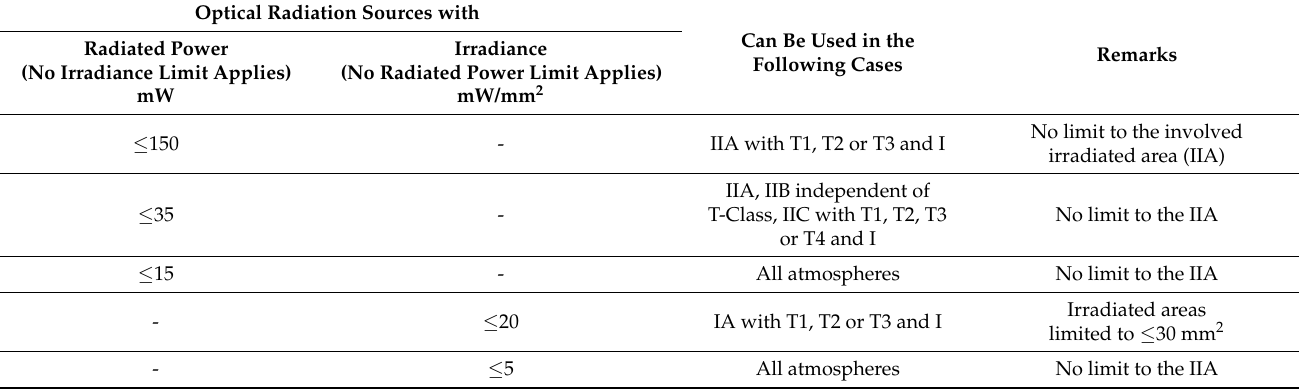
Table 1. Safe optical power and irradiance for Group I and II equipment, categorized by Equipment Group and temperature class [3].